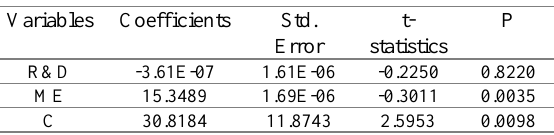
Table 6. Panel OLS results